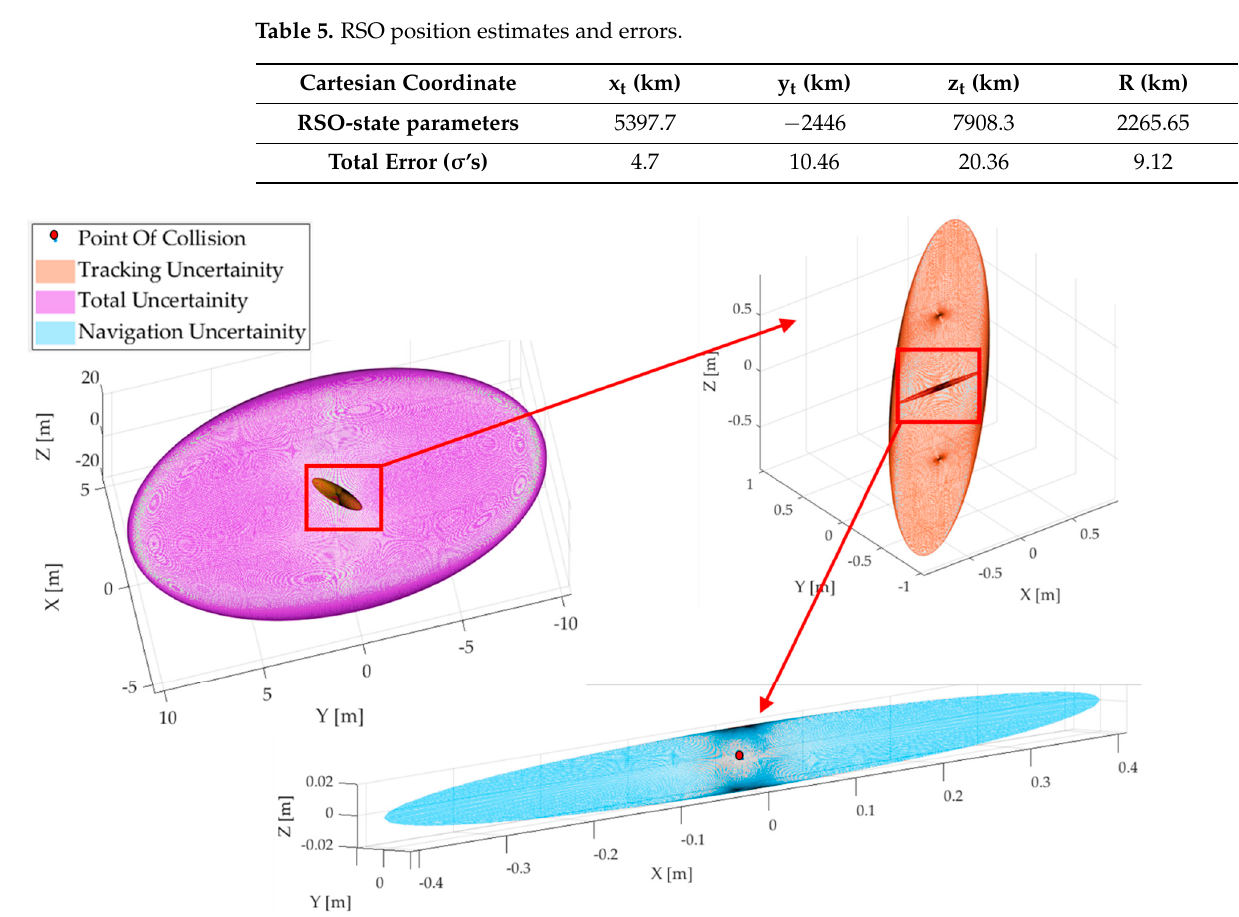
Table 6. Ground-based sensor